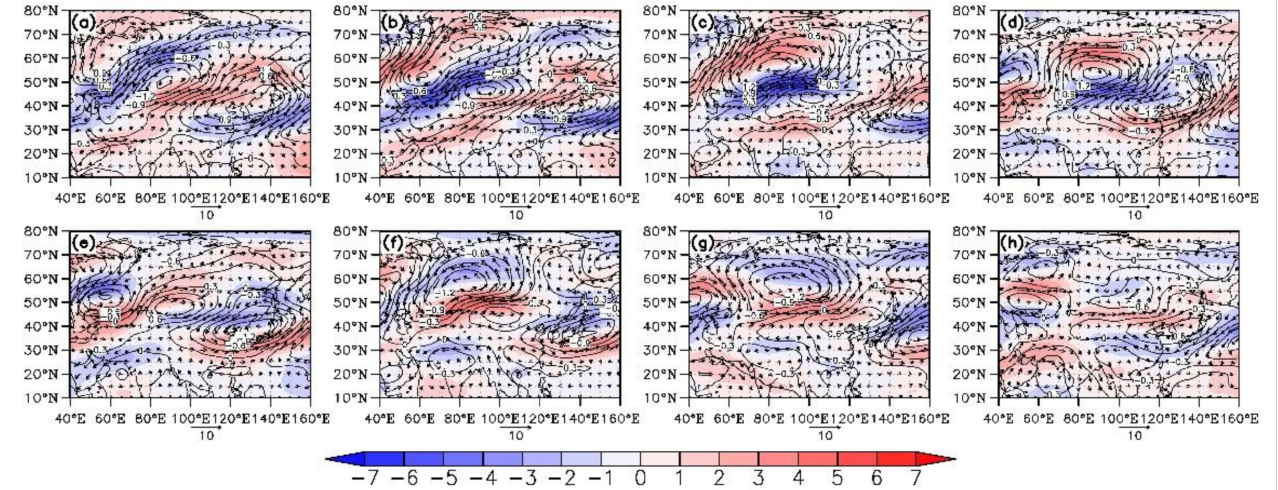
Figure 9. Composition of the 300 hPa 10–20 d filtered zonal wind field (shaded, unit: m/s), 300 hPa full wind speed (arrow, unit: m/s), and the 500hPa temperature field (contour, unit: ◦ C) 7 days before and after day 0 in WPECE (( a – h ): –7 d, –5 d, –3 d, –1 d, 1 d, 3 d, 5 d, 7